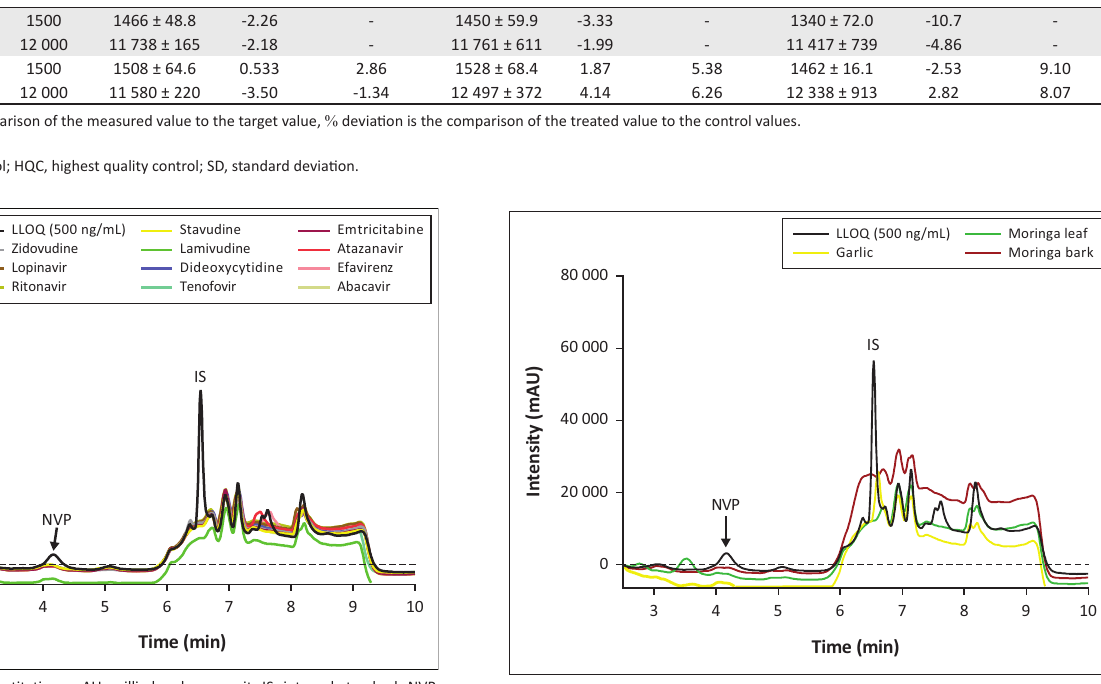
FIGURE 3: Chromatogram overlay of LLOQ with antiretrovirals, no interference was observed at nevirapine and internal standard retention times for all antiretrovirals.